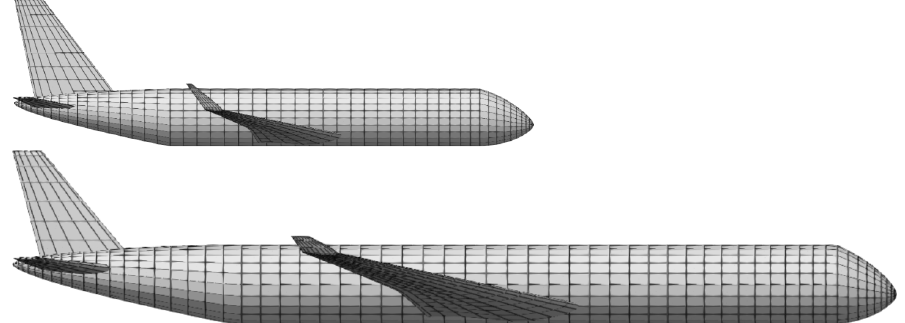
Figure 1. Side view of the geometrical models generated by FRIDA for the single- ( top ) and the twin-aisle ( bottom )